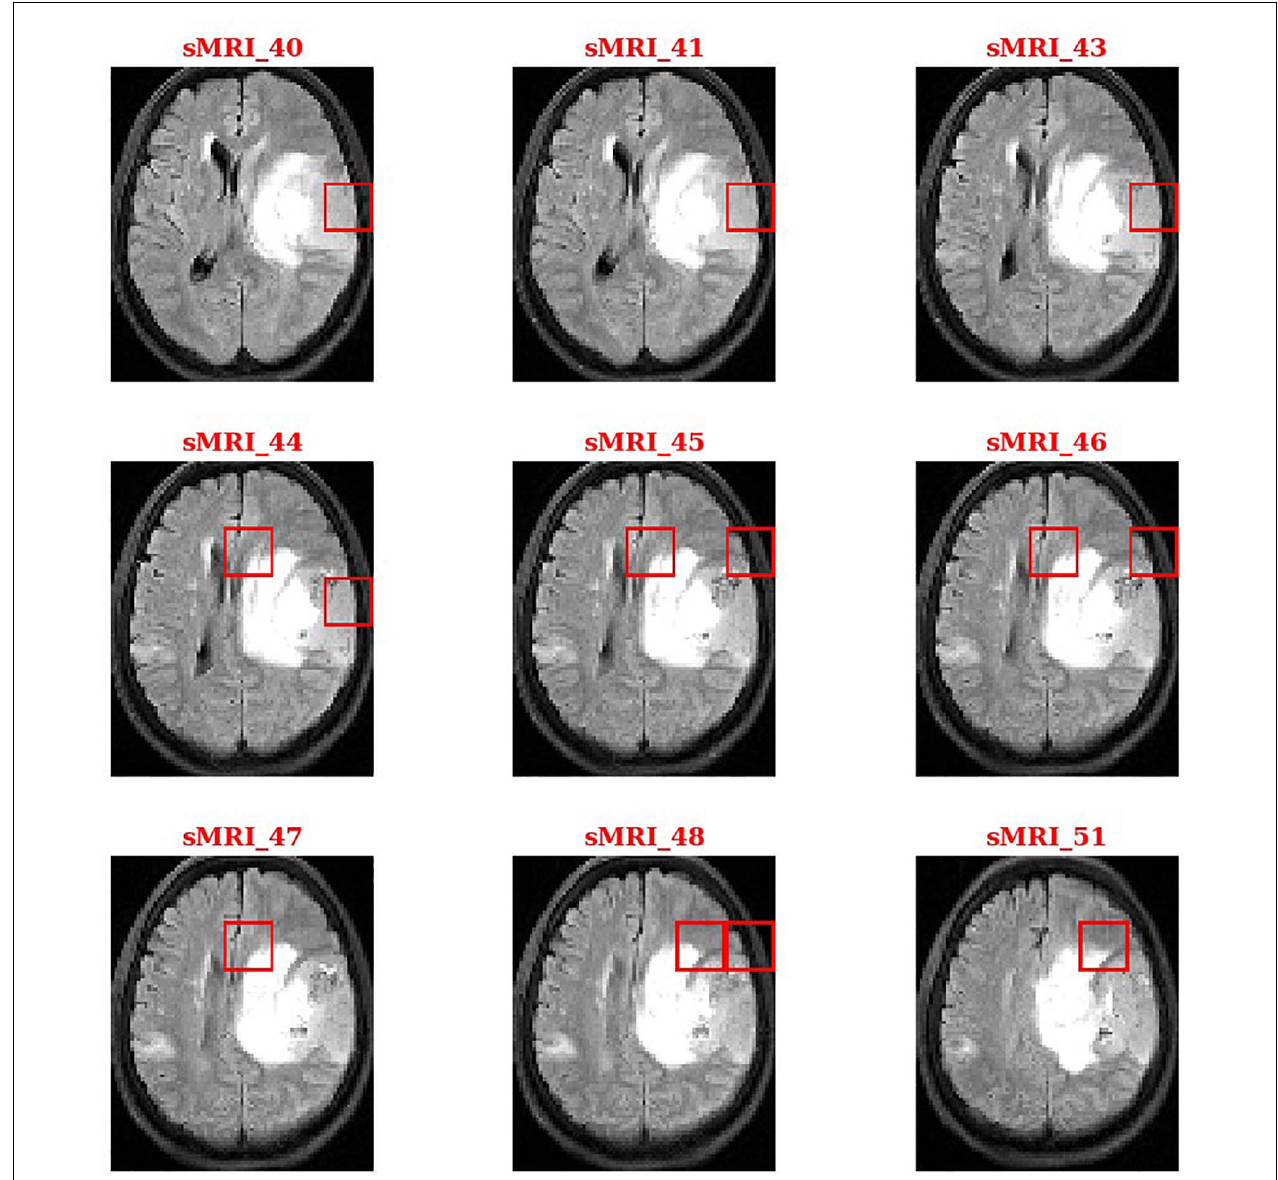
FIGURE 4 | Discriminant features related to brain